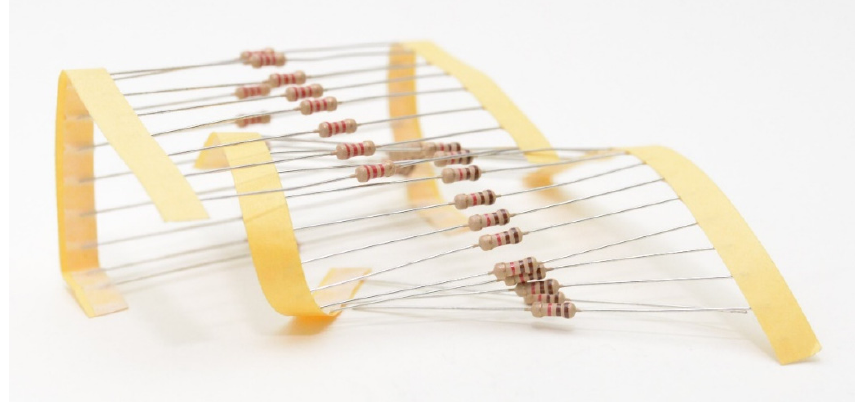
Figure 1. Typical layered EOL resistors fitted as equipment for intrusion detection systems (IDS).